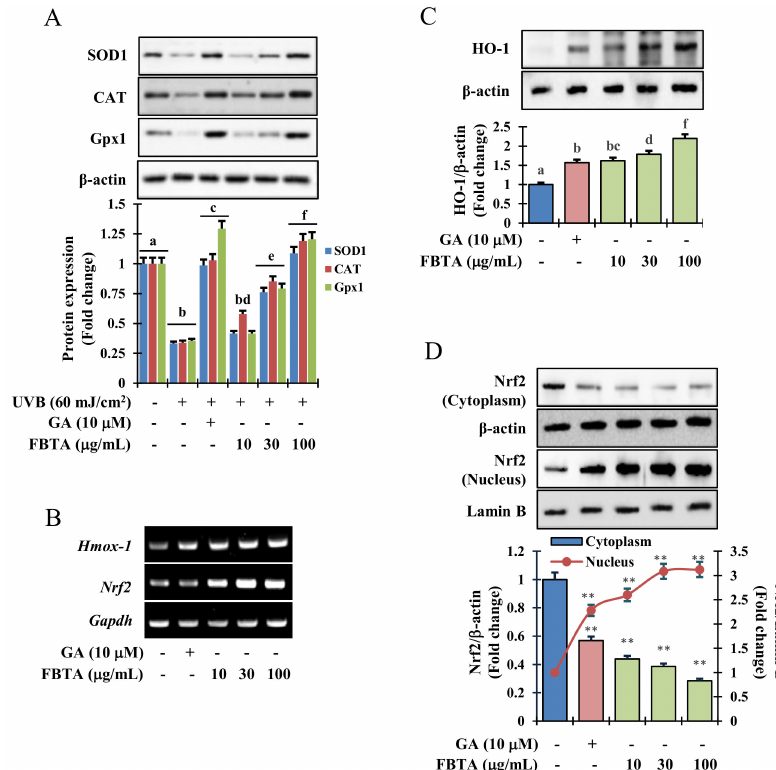
Figure 4. Effects of FBTA on the antioxidant enzyme expression through the nuclear factor erythroid 2-related factor 2 ( Nrf2 ) signaling pathway. ( A ) FBTA pretreated HaCaT cells were exposed with UVB (60 mJ/cm 2 ), and the protein expression of superoxide dismutase 1 (SOD1), catalase (CAT), and glutathione peroxidase 1 (GPx-1) was detected by immunoblotting. The different letters of each column indicate significance ( p < 0.05); ( B ) After treatment of HaCaT cells by FBTA, messenger RNA (mRNA) expressions of Hmox-1 and Nrf2 were detected by RT-PCR. ( C , D ) Heme oxygenase 1 (HO-1) and Nrf2 expressions were detected by immunoblotting. Densitometric analysis was carried out to quantify the band intensity by β -actin normalization. ** p < 0.01 compared to the normal cells. GA: gallic acid. Different letters (a, b, c, d, e, f, g, bc, bd) are denoted as the statistical